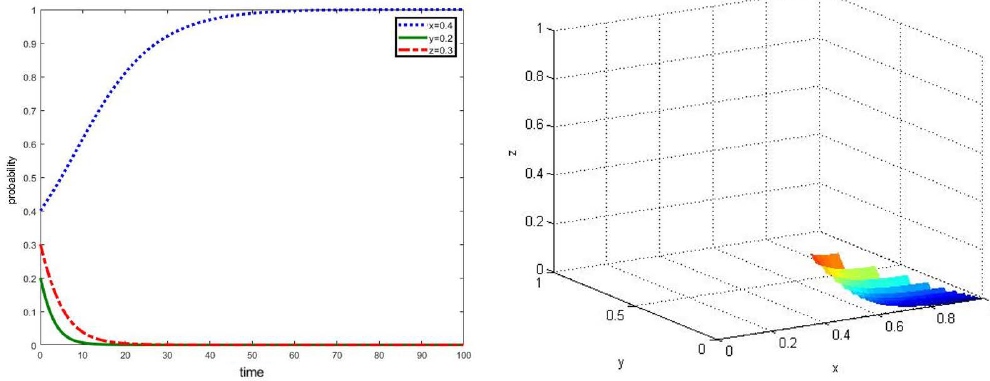
Figure 4. Simulation of dynamic evolution in the scenario of parameters under the conditions of 3 (cid:79)